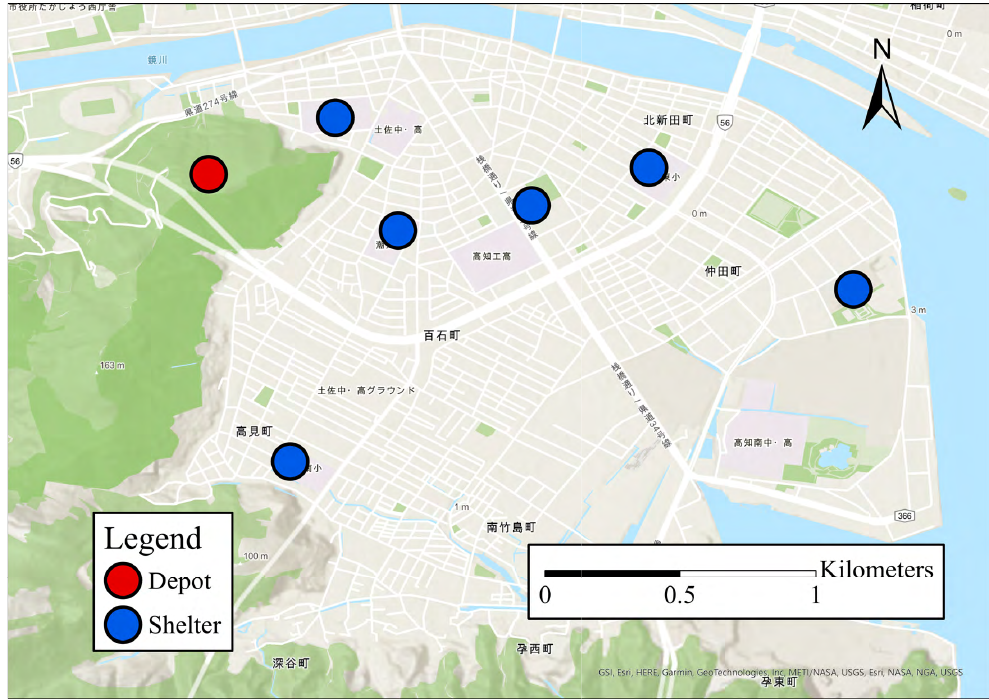
Figure 1. Depot (red) and shelters (blue) in Ushioe district in Kochi City, Kochi Prefecture, Japan. A set of shelters S = { 0, 1, 2, . . . , N S } are set up in the area, where ( j = 0 ) is the depot and the set of { 1, 2, . . . , N S } represents shelters where emergency relief supplies are delivered. In this study, one shelter, which is not inundated by the tsunami, is set as depot ( j = 0 ) for the transportation of supplies, and a logistics model is developed for transporting supplies from the depot to the other six shelters ( N S =